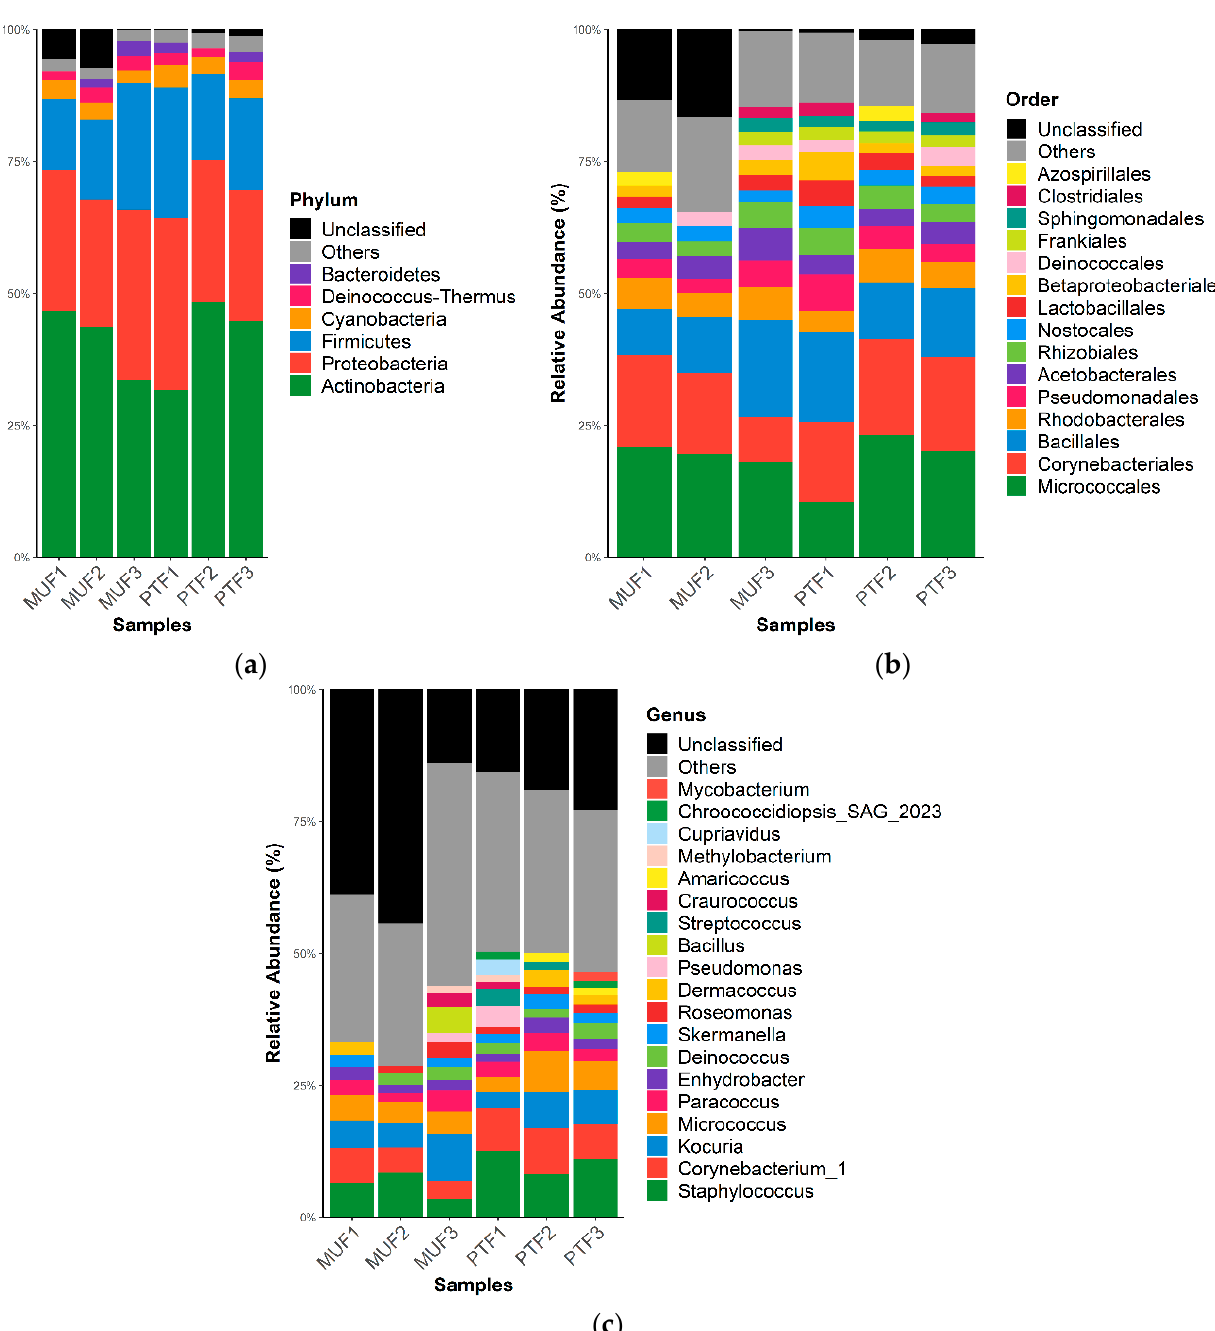
Figure 2. Bacterial relative abundance (%) at the ( a ) phylum, ( b ) order, and ( c ) genus levels in MUF and PTF samples. The data are reported as relative abundances (%) of taxa with abundances of ≥ 1%.